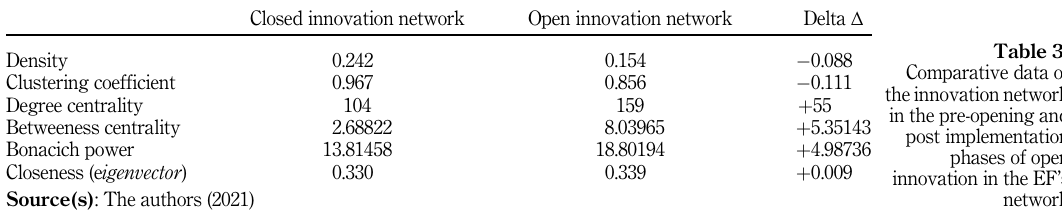
Table 3. Comparative data of the innovation network in the pre-opening